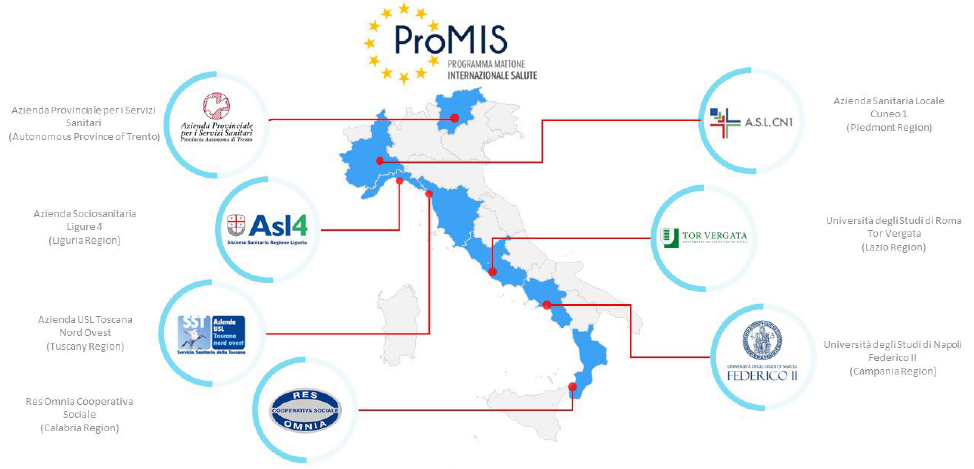
Figure 2. Location of the centers participating in SUNFRAIL+ on the map representing the Italian regions (Italy).